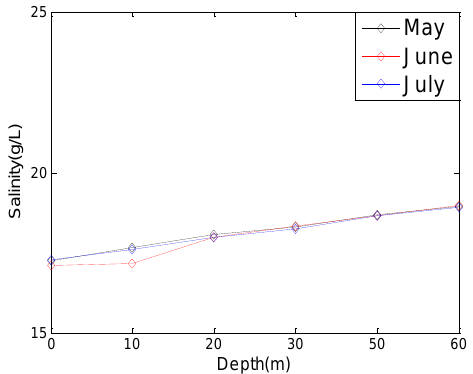
Figure 6. Average salinity with different water depths.